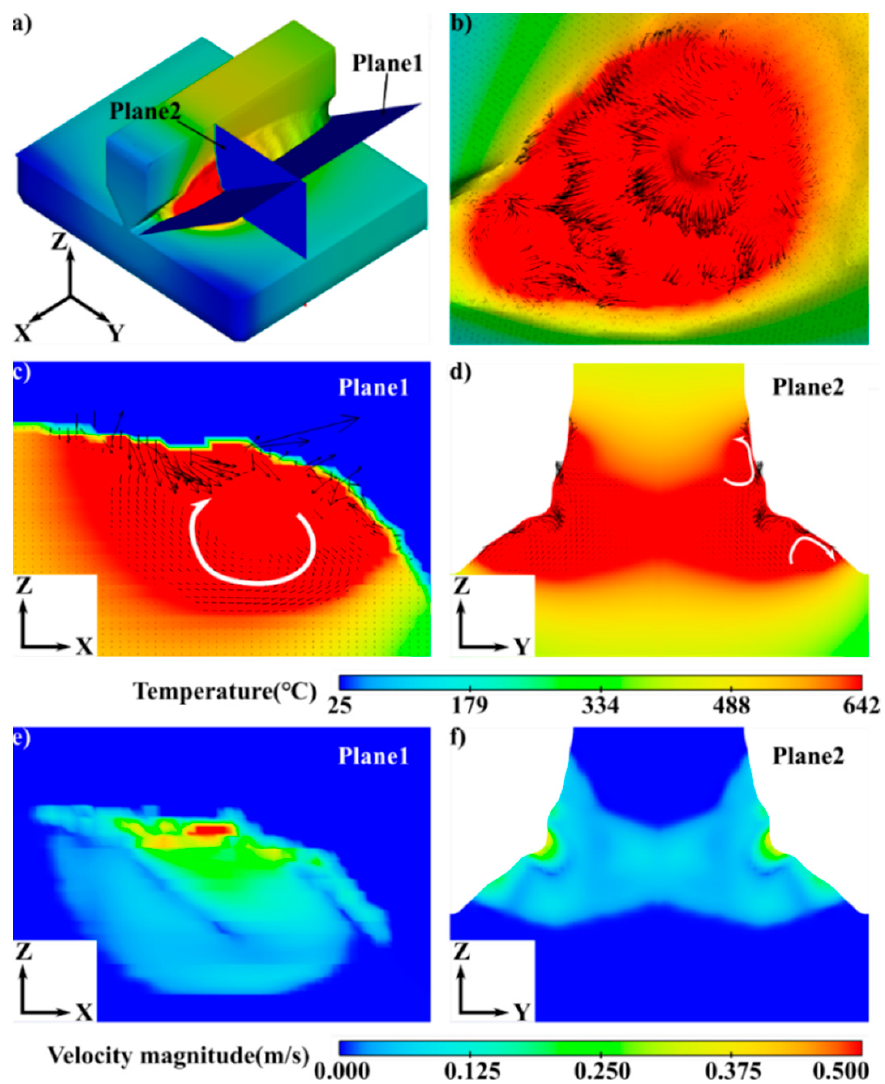
Figure 6. Molten pool flow characteristics: ( a ) locations of clip planes; velocity vectors on the ( b ) top surface, ( c ) longitudinal section, and ( d ) cross-section of the molten pool; velocity magnitude distribution on the ( e ) longitudinal section, and ( f ) cross-section of the weld bead. Figure 7 shows the temperature contours and velocity distributions at different weld- ing times. The cross-section was also extracted at the droplet falling position shown in Figure 6a. The droplet transfer and Marangoni stress are the leading driving force through- out the whole welding process. The flow behaviors at different times are similar to those shown in Figure